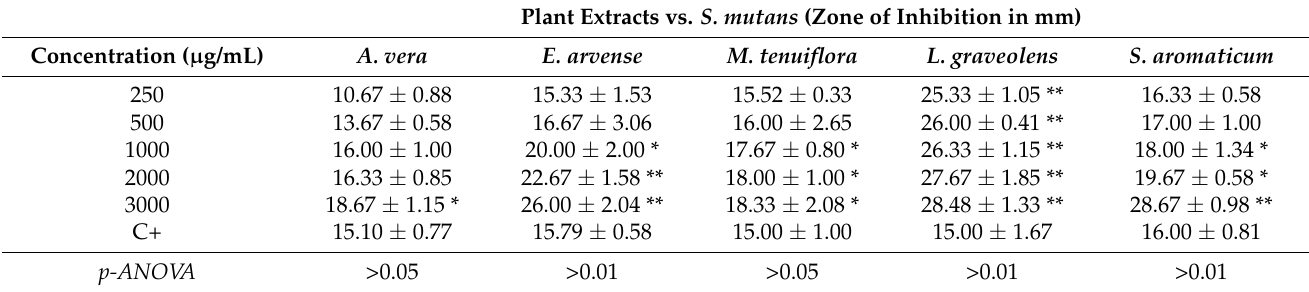
Table 3. Activity of ethanol extracts against S. mutans . Plant Extracts vs. S. mutans (Zone of Inhibition in mm)